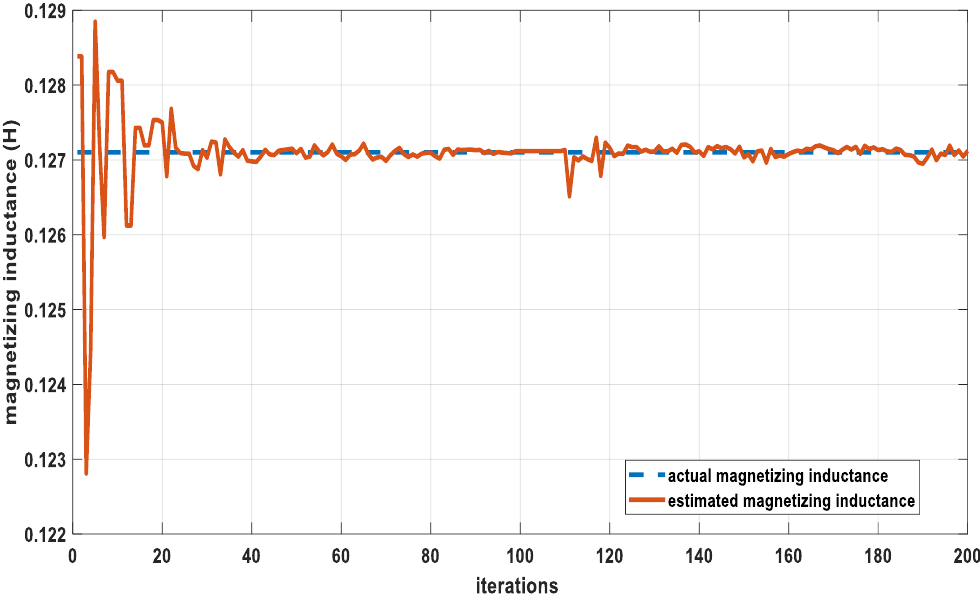
Figure 7. Magnetizing inductance versus iteration numbers.